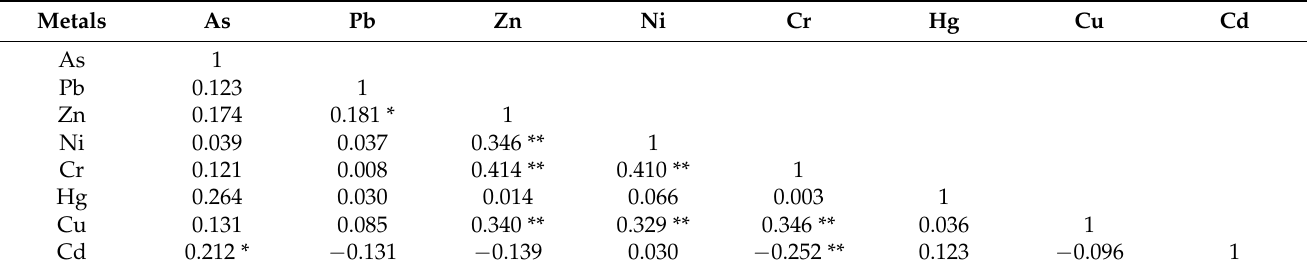
Table 6. Correlation analysis of heavy metal